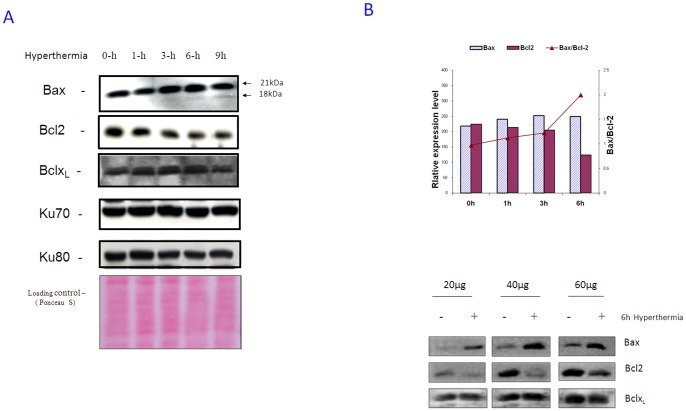
Hyperthermia affects expression levels of different apoptosis-related proteins.
A.Whole cell extracts were prepared at indicated periods after 42.5°C hyperthermia and Bax, Ku70, Ku80 and Bcl-2 were analyzed by immunoblotting. Slight increase in Bax only after 6 and 9 h hyperthermia and limited Bax activation after 9 h are observable. Hyperthermia reduced Bcl-2 while Bcl-xL and Ku70 had not been clearly affected. Anaysis was performed in the same blot so each protein worked as a loading control for the other. A representative Ponceau S staining of the membrane was shown to verify the normalization because most of the basic house-keeping genes (e.g: actin and tubulin) are responding to hyperthermia. B. Quantitative analyses of Bcl-2 and Bax protein expression during hyperthermia. Each band was quantified densitimetrically. A representative set of Bax/Bcl-2 ratio is shown. Western analysis with different loading amount of PC-10 cells lysates after 6 h hyperthermia verifies the change in the Bax/Bcl-2 ratio, while Bcl-xL expression was used as a loading control from same blot.